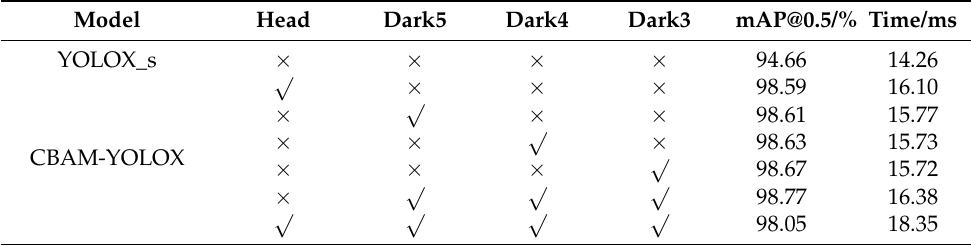
Table 2. Detection accuracy and speed of different versions of CBAM-YOLOX